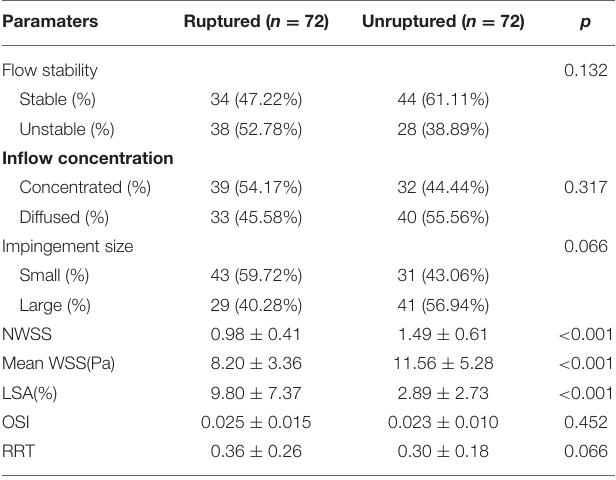
TABLE 3 | Result of univariate statistical analysis for hemodynamic parameters. Paramaters Ruptured ( n = 72)